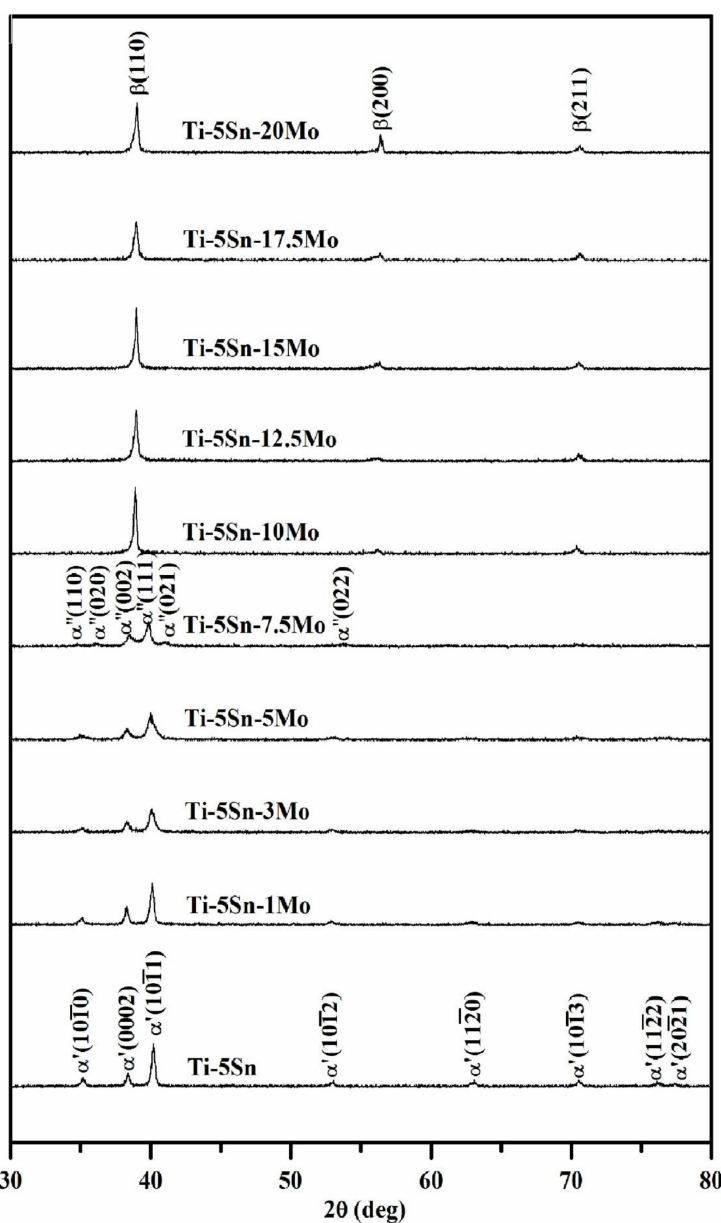
Figure 1. XRD patterns of as-cast Ti–5Sn and Ti–5Sn– x Mo